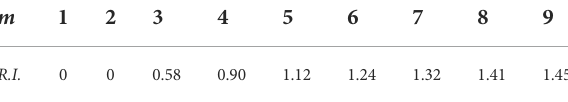
TABLE 1 Average stochastic consistency indicator